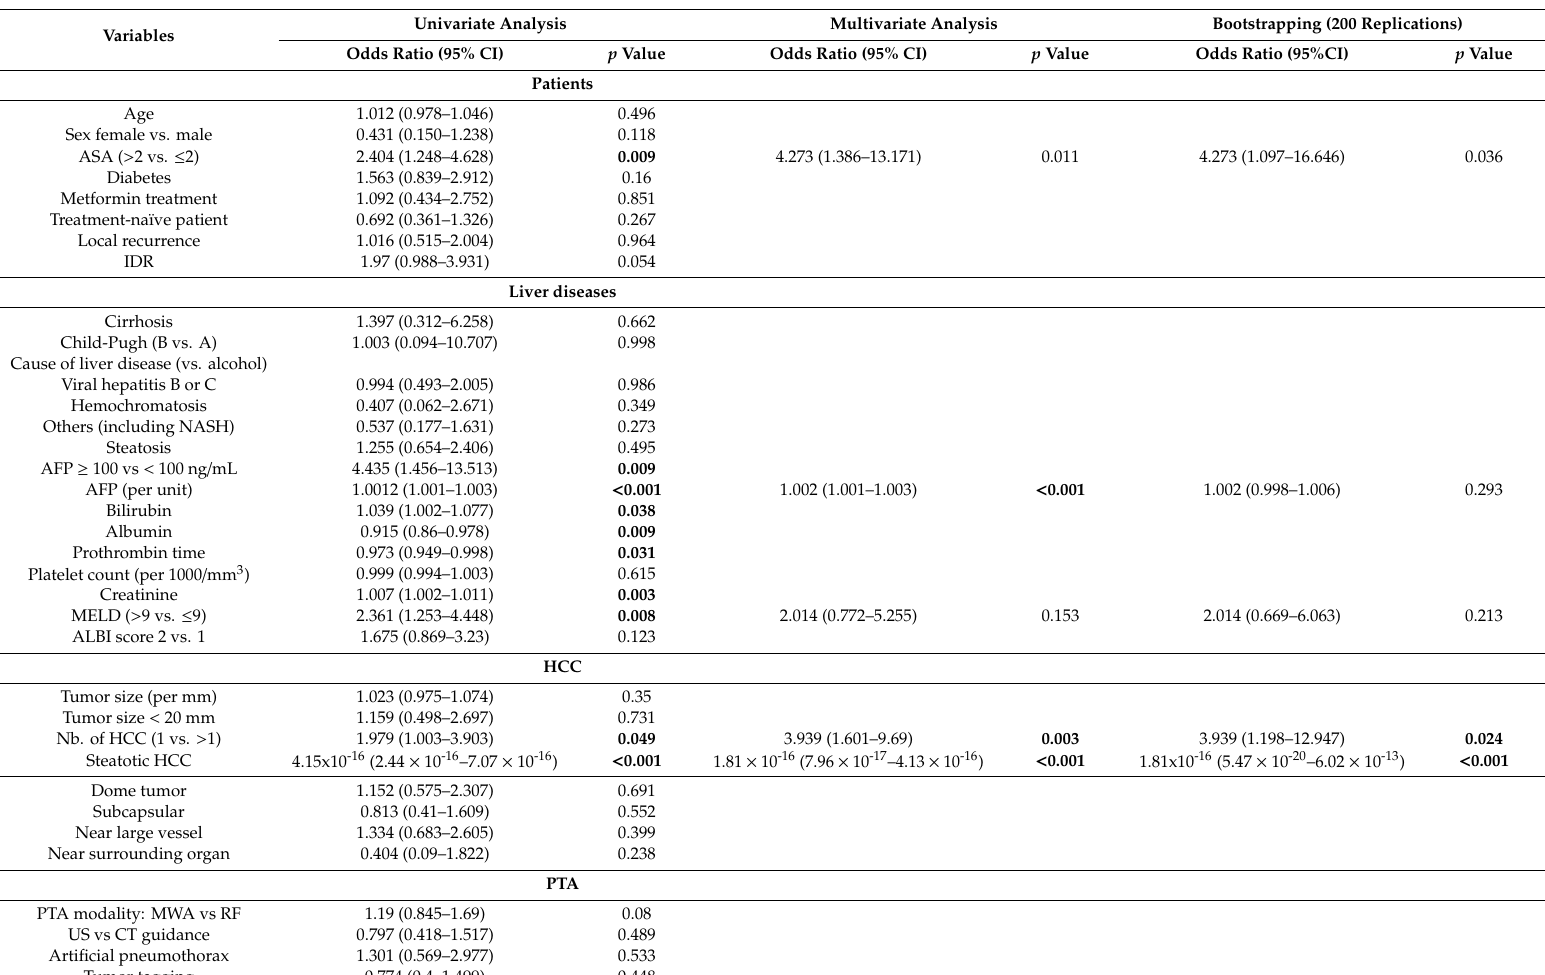
Table 4. Univariate and multivariate Cox regression models to predict overall survival (per patient